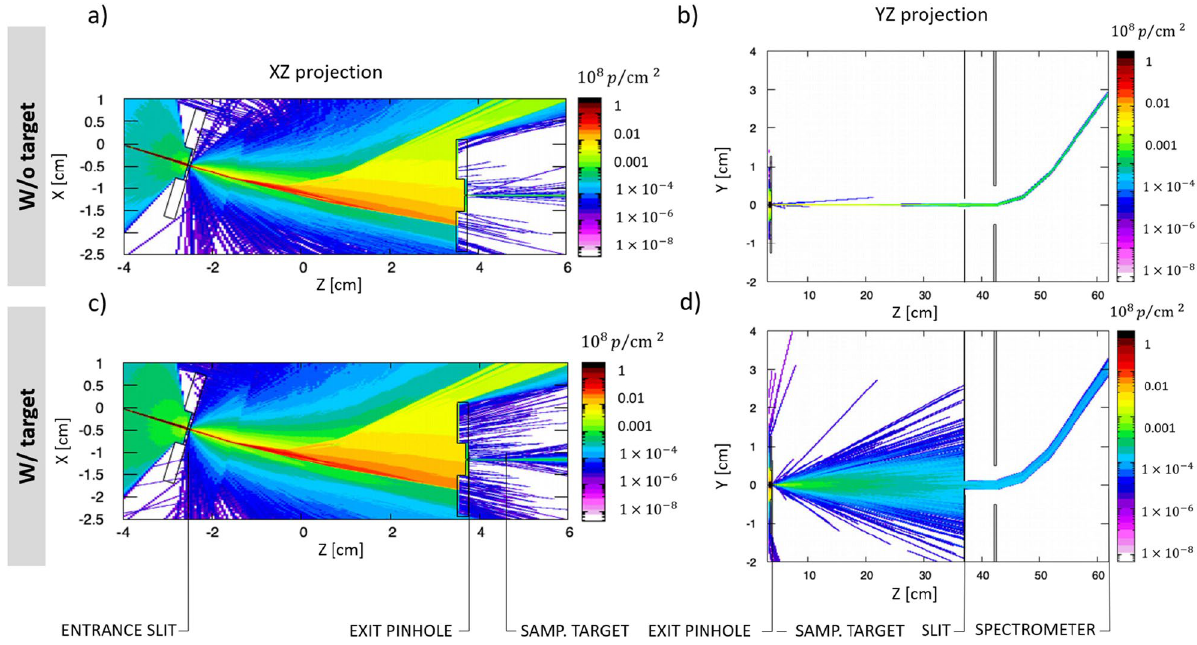
Figure 7. Monte-Carlo simulations performed with the FLUKA MC code. ( a ) The protons enter through 1.2 T magnetic field, and 500 keV protons are selected by the exit the entrance slit, are deflected by the B y = 0.2 T magnetic field of MCP spectrometer. ( c ) pinhole. ( b ) Propagation of protons and deflection by the B x = and ( d ) Equivalent simulations including a 2 µ m Mylar target. Scattering in the target increases the proton divergence and only part of the beam is sampled by the entrance pinhole of the